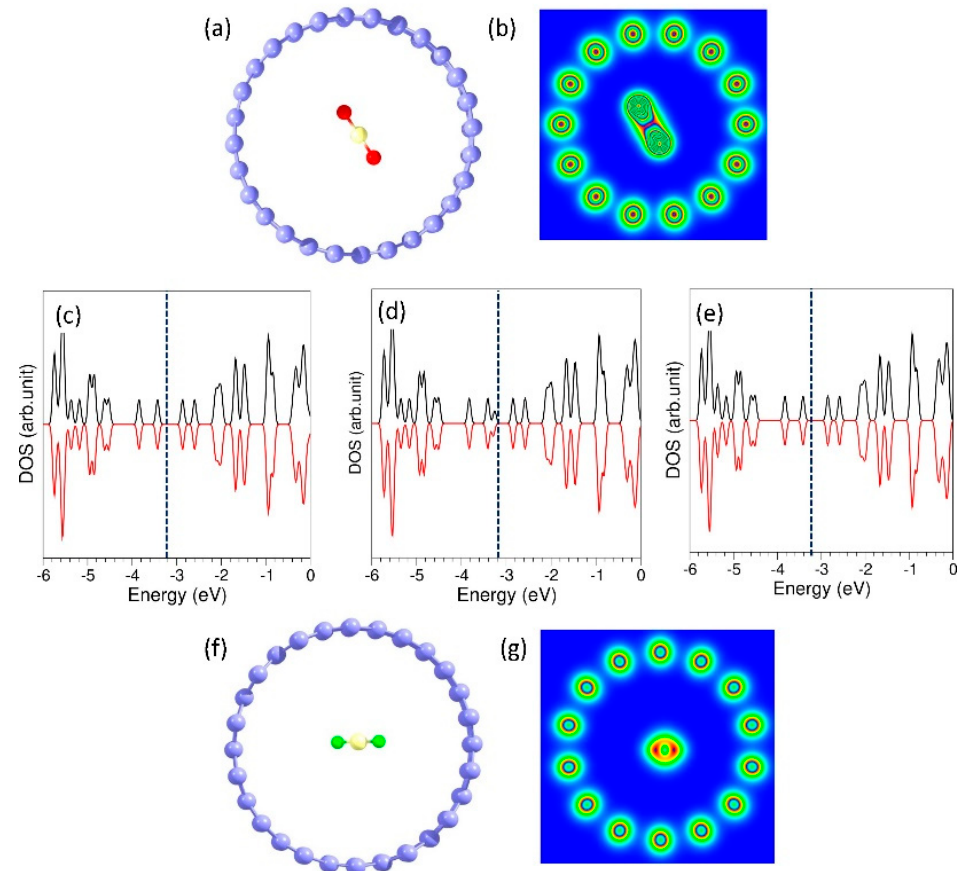
Figure 1. ( a ) Relaxed structure of a single SO 2 molecule encapsulated within SWNT, ( b ) charge density plot showing the interaction of SO 2 molecule with nanotube, ( c ) DOS plot of a pristine SWNT, ( d ) DOS plot of SO 2 @SWNT, ( e ) DOS plot of H 2 S@SWNT, ( f ) relaxed structure of a H 2 S molecule inside the nanotube, and ( g ) its charge density plot. Vertical dashed lines correspond to the Fermi level. Table 1. Calculated encapsulation energies with respect to molecules, the amount of charge trans- ferred between the nanotube and the molecule, and net magnetic moments of the pristine nanotube and the encapsulated complexes.